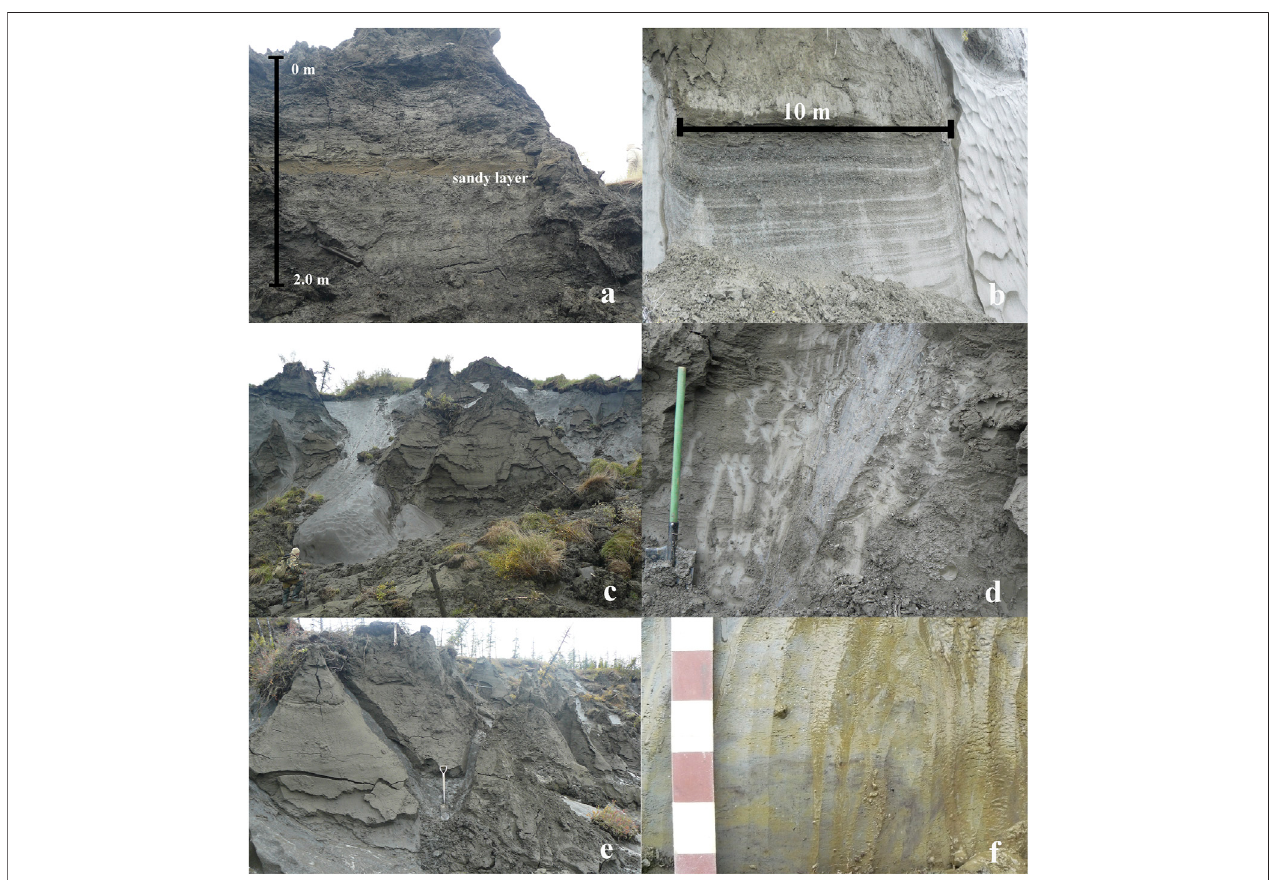
FIGURE 2 | Cryolithological features of the Duvanny Yar exposure. (A) – sandy layer at 8 – 10 m above the Kolyma level, Unit A ; (B) – low-center polygon deposit, Unit A; (C) – the exterior of Unit B ; (D) – mineral part of Unit B ; (E) – baidzerakh and ice wedges, Unit B ; (F) – organic inclusions and cryoturbation traces, Unit C .